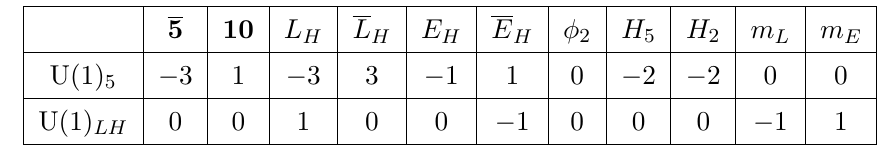
Figure 1. The running of the SM gauge couplings (solid lines). The red and green dashed lines denote the matched values of α 2 H and α 1 H for a given fake GUT scale (see eqs. (3.19)). The fake GUT scale is required to be below M upper ’ 10 14 . 4 GeV. X